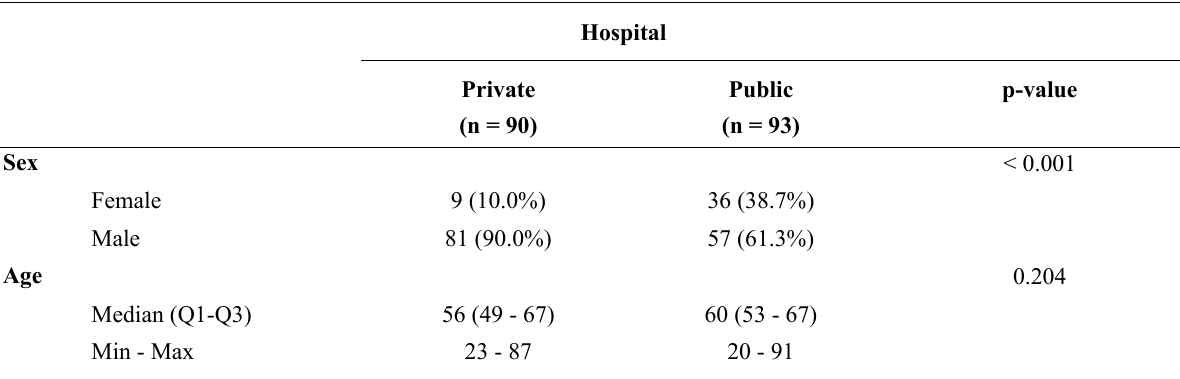
Table 1 - Demographic